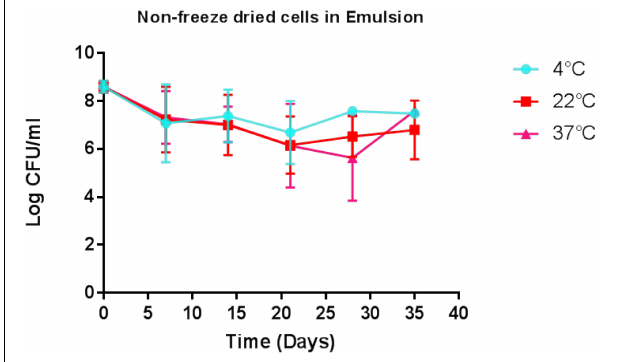
FIGURE 2 | Viability of the ‘live bio-therapeutic’ formulation in a liquid paraffin/polysorbate 80-based emulsion prepared from washed cell preparation and stored at 4, 22, and 37 ◦ C. Determination of viability of L. lactis DPC3147 cells in a liquid paraffin-based emulsion (with a final concentration of 2.5% polysorbate 80) (“live bio-therapeutic’ formulation). Error bars represent standard deviations of mean values in each